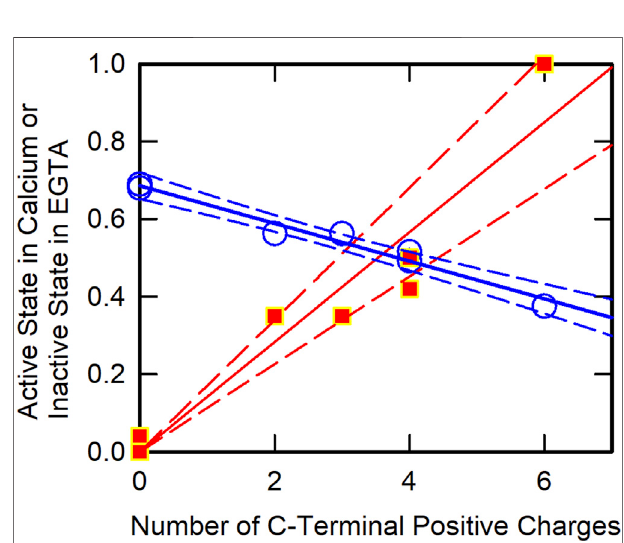
FIGURE 3 | C-Terminal TnT Charge Effects on Actin Filament States. The fraction of actin in the active state at saturating Ca 2+ was determined by ATPase assays (green circles). The fraction of actin in the inactive state in the virtual absence of Ca 2+ was determined by acrylodan tropomyosin fl uorescence (red squares). Data were obtained from earlier publications (Johnson et al., 2018), (Johnson et al., 2019) with linear least square fi ts (solid lines) and 95% con fi dence limits (broken